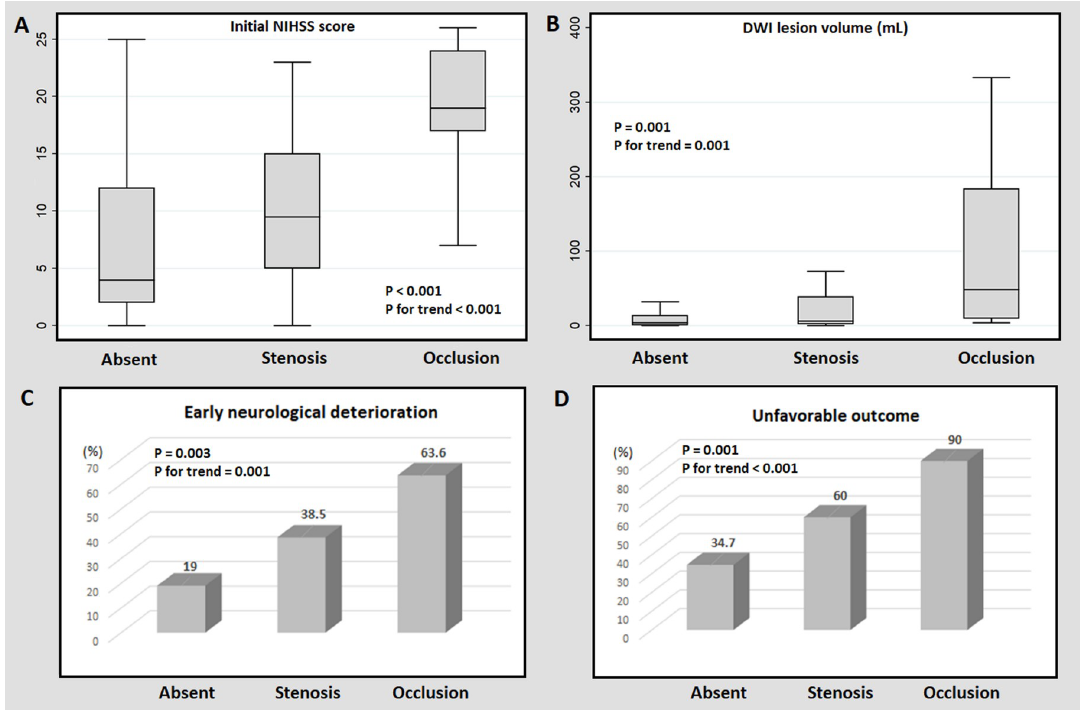
Fig 1. Comparison of the prognosis according to the intracranial atherosclerosis lesion burden. Patients with occlusive ICAS lesions had higher initial NIHSS scores (A), larger DWI lesion volumes (B), more frequent END, (C) and more unfavorable outcomes (D) as compared to the other patients. ICAS = intracranial atherosclerosis, NIHSS = National Institutes of Health Stroke Scale, DWI = diffusion-weighted imaging, END = early neurological